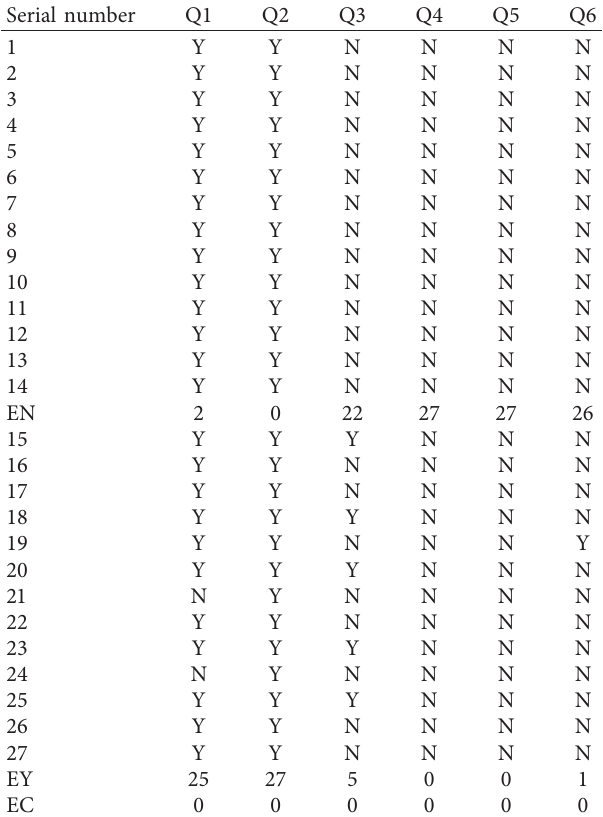
Table 6: Normative evaluation